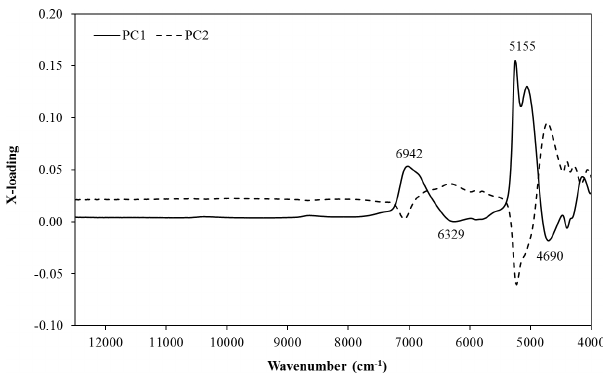
Fig. 5. x -loading plot of PC1 and PC2 from PCA